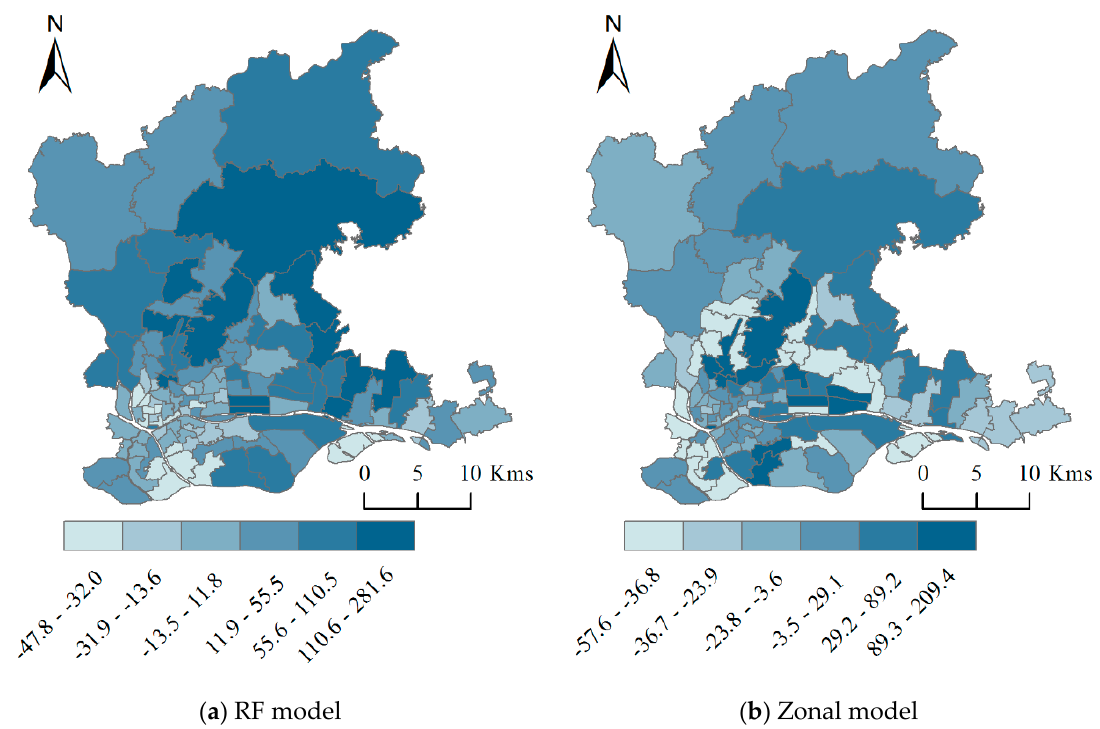
Figure 9. Distribution map of mean relative error (MRE) in two models.